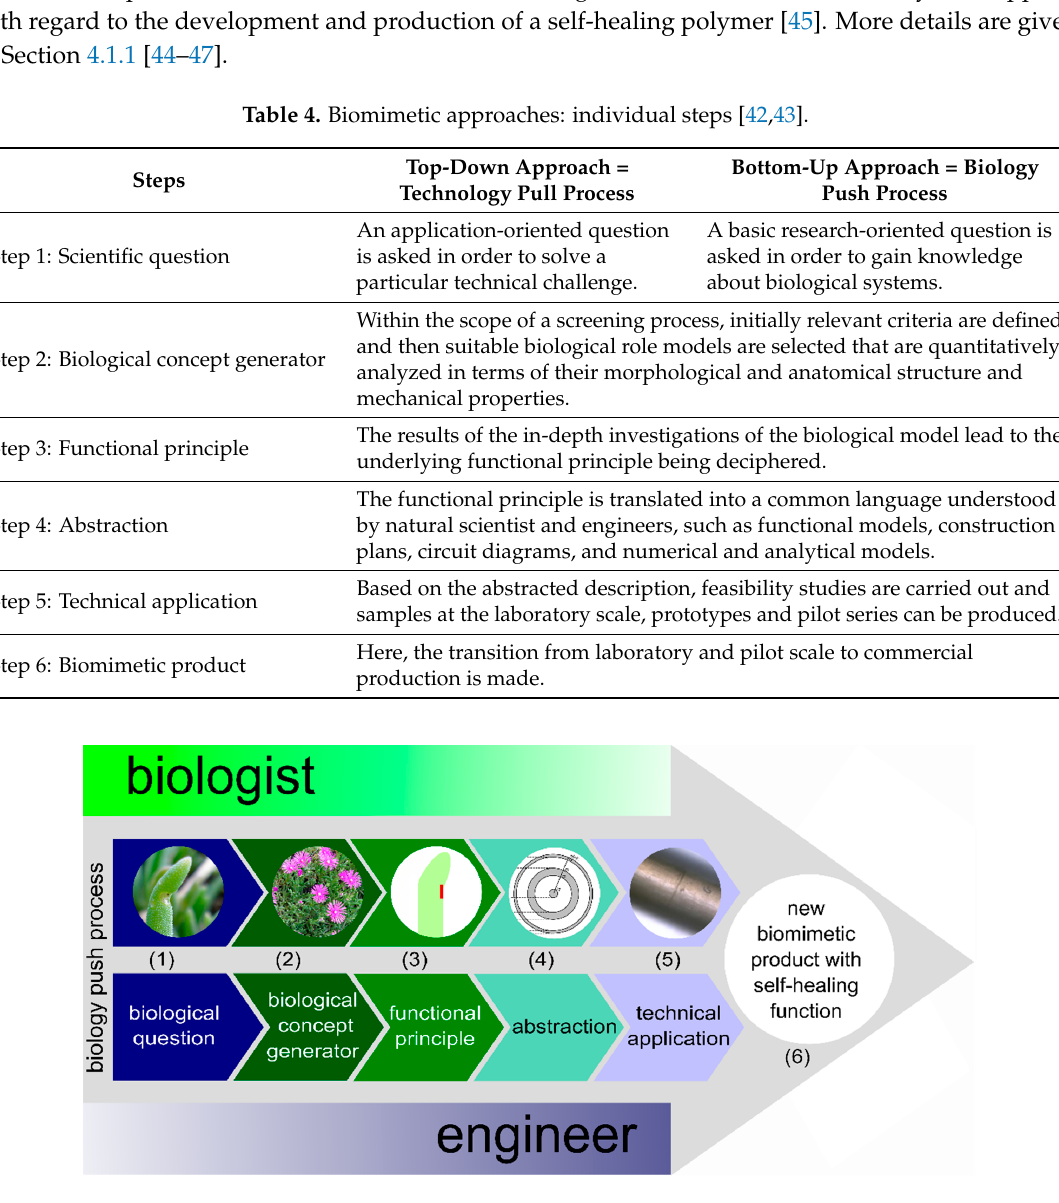
Figure 6. The bottom-up approach (biology push process) of a project aimed at revealing biological self-repairing functions. (1) What is the basis of the self-sealing function of an entire plant organ? (2) The Pink Carpet ( Delosperma cooperi ) has proved to be a suitable concept generator. (3) An effective self-sealing function by internal deformation has been found in the succulent leaves of D. cooperi. (4) The underlying sealing principle is a combination of hydraulic shrinking and swelling as the main driving forces and growth-induced mechanical prestresses in the five tissue layers also acting as a speed-boost mechanism. (5) Inspired by the mechanically driven deformation of the plant leaves, a polymer with a shape-memory effect was developed that finally leads to self-healing (reprinted from [45], Copyright 2018, with permission from Elsevier). (6) Since the leaf-inspired polymer has only recently been developed, a specific application is not yet available. Slightly modified and reproduced with permission from [4] Copyright © 2015.